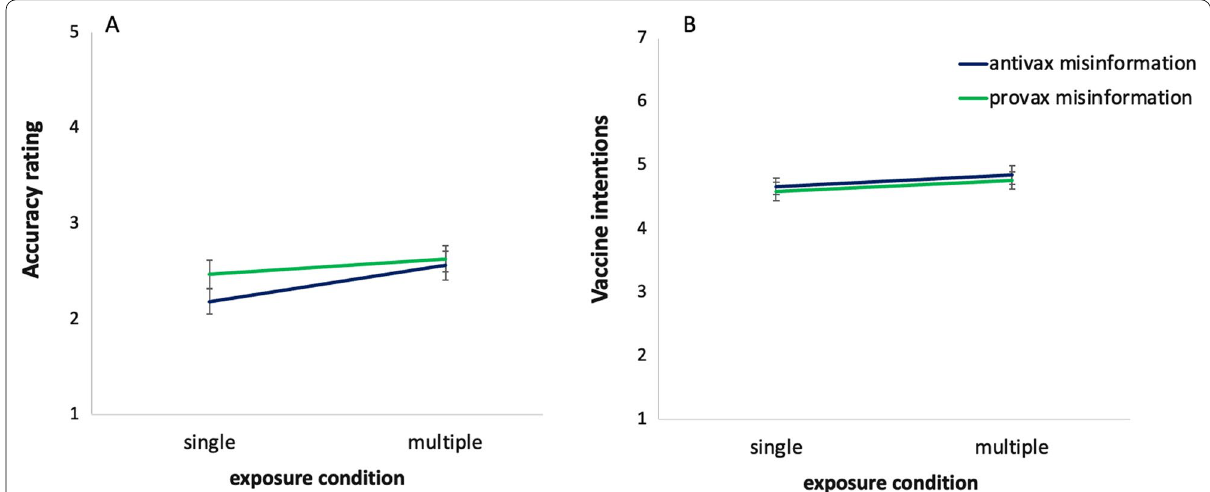
Fig. 5 A Perceived accuracy and B vaccination intentions adjusted for pre-existing vaccine opinions following single or multiple exposure to novel (fake) headlines in Study 3. Error bars represent 95% confidence intervals. Note that while multiple exposures increased accuracy ratings, especially for anti-vaccine misinformation, there was no corresponding effect on vaccine